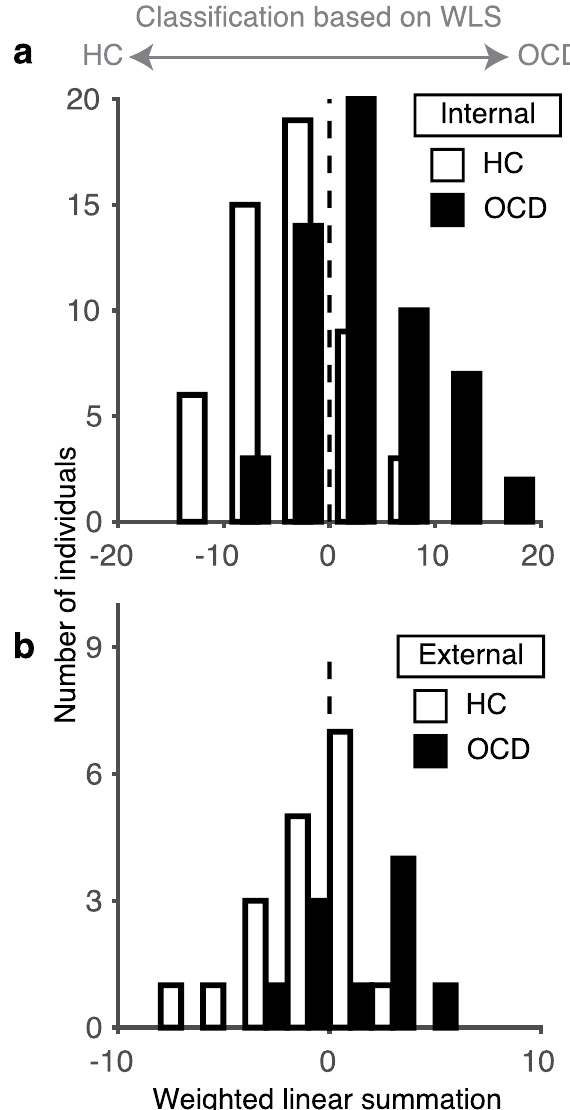
Figure 2. Distribution of WLSs of functional connections used for the classification of the OCD and HC populations. ( a ) The number of HC (white) and OCD (black) participants in the internal dataset in a specific WLS interval of width 5 is shown as a histogram. ( b ) WLS for the validation dataset in a specific WLS interval of width 2 is shown as a